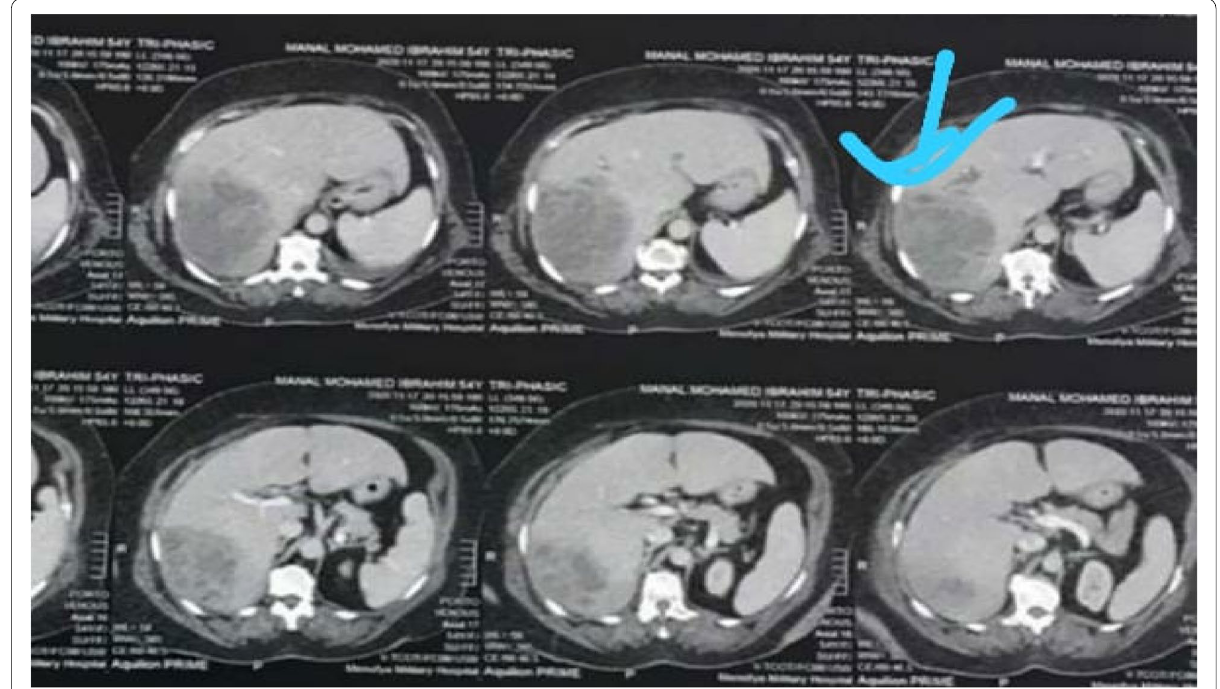
Fig. 2 A large right lobe liver abscess with a potential biliary linkage in a